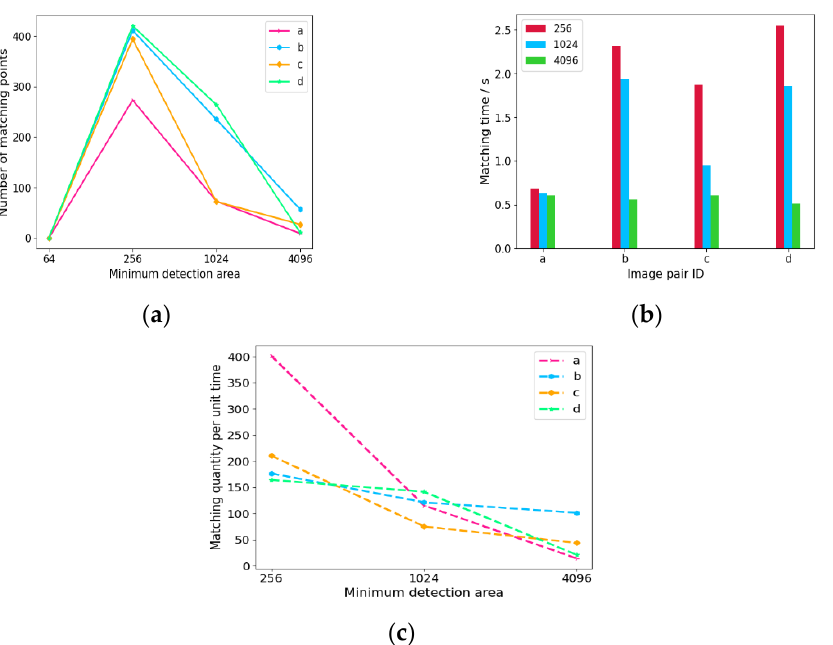
Figure 5. Matching performance with different values of S : ( a ) number of matching points, ( b ) computer time of the matching process (matching time), and ( c ) number of matches per unit time.